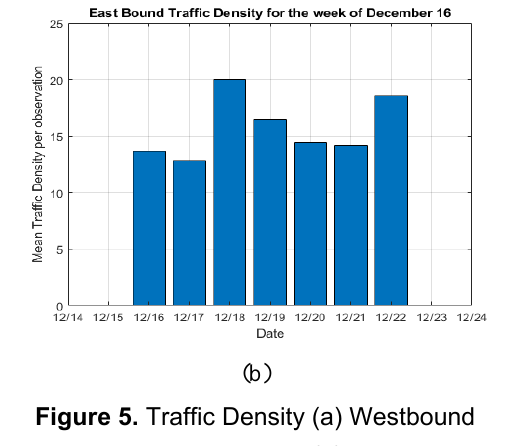
(b) Figure 5. Traffic Density (a) Westbound (b) East